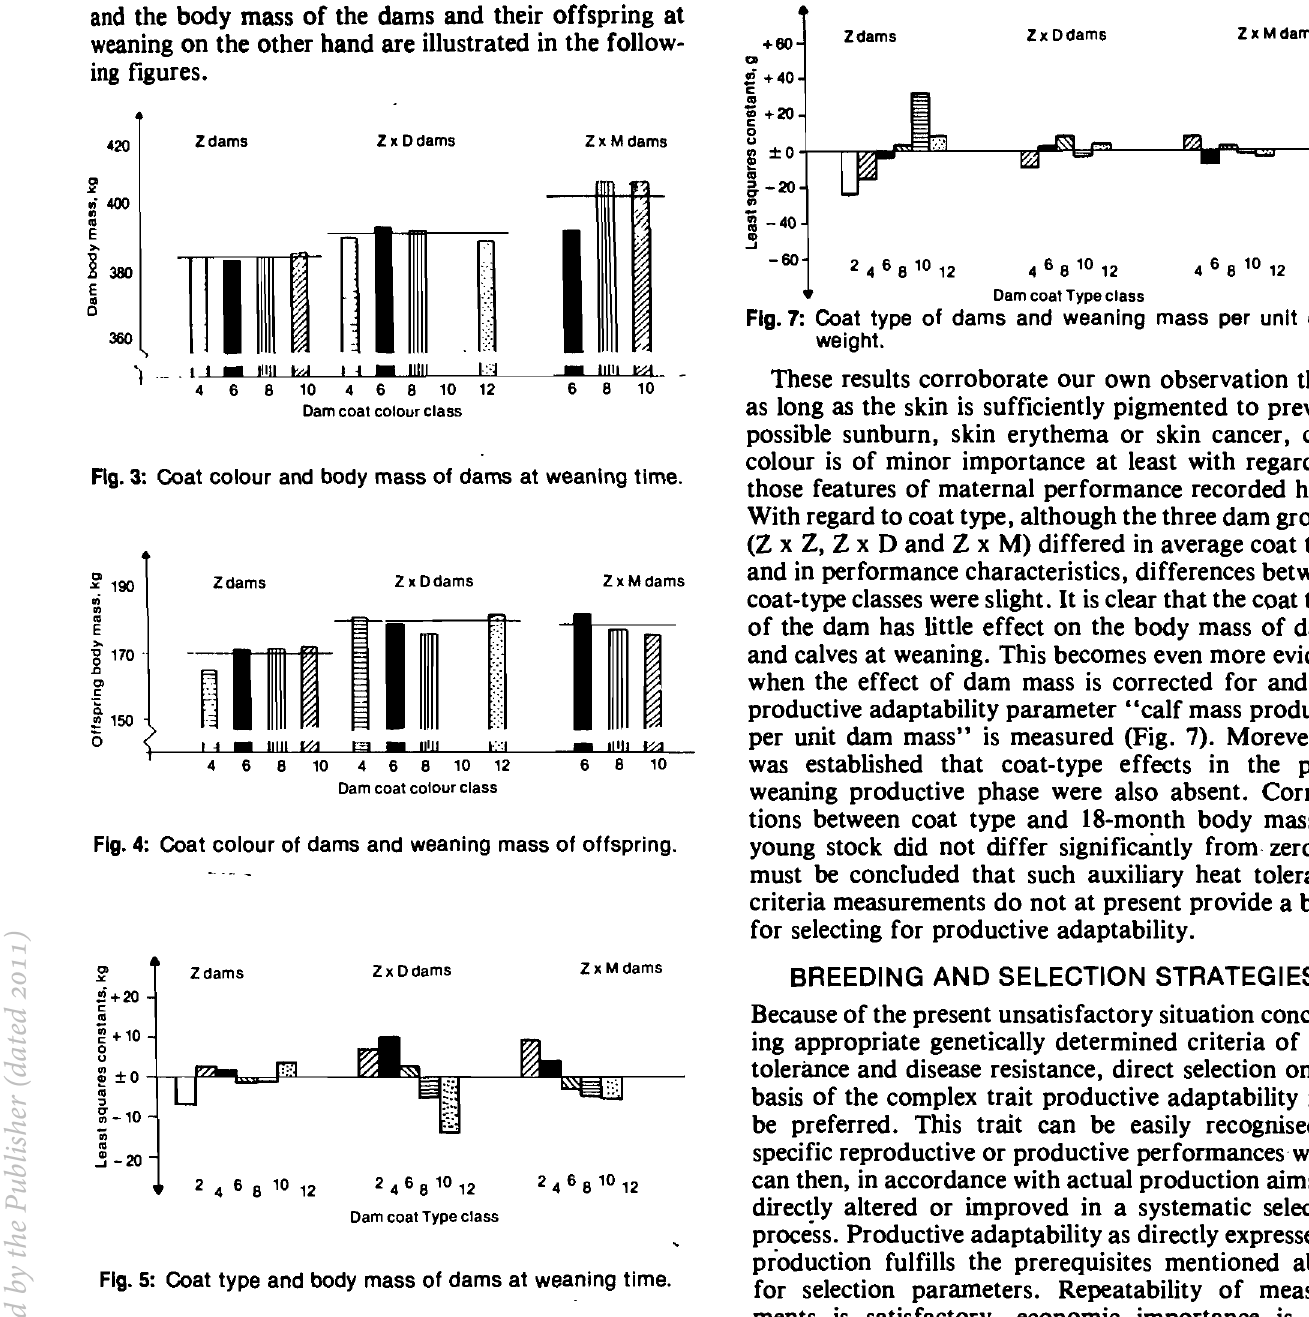
Fig. 5: Coat type and body mass of dams at weaning time.